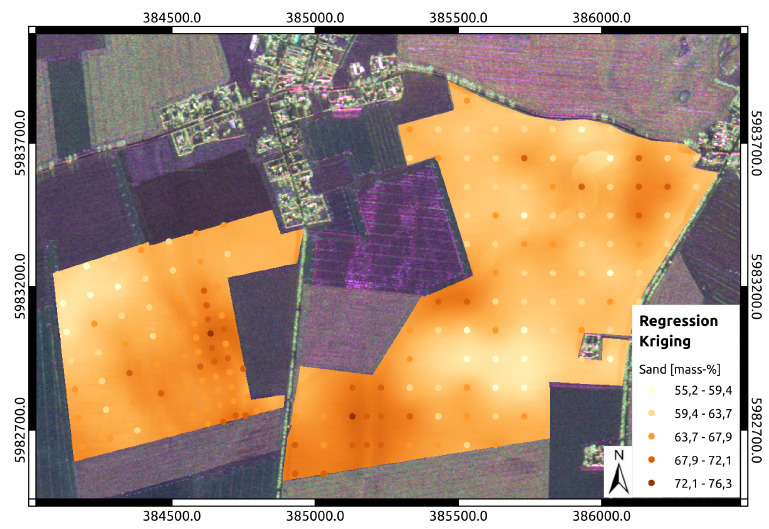
Figure 8. Spatial interpolated soil map for the texture class sand based on the Regression Kriging (RK) approach. Circles display the sample locations and colors are scaled in the same color as background sand